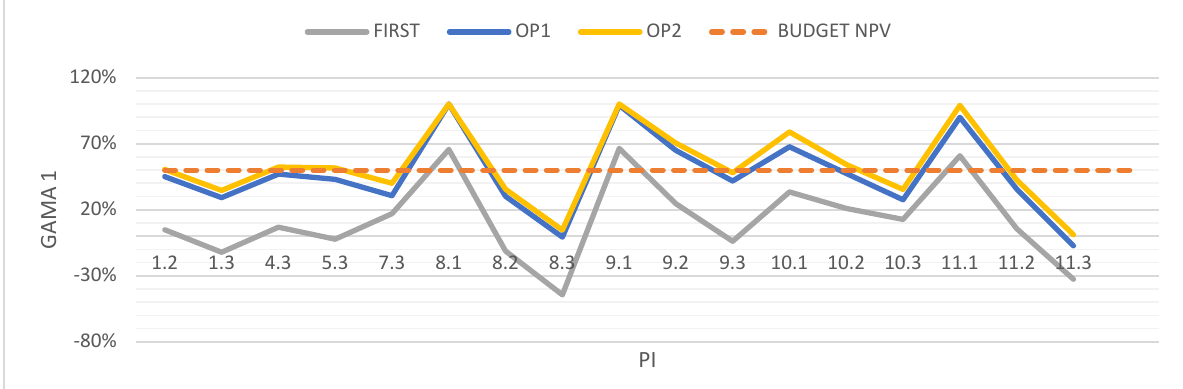
Fig. 11. Net Present Value (Robust Model) (Owner)